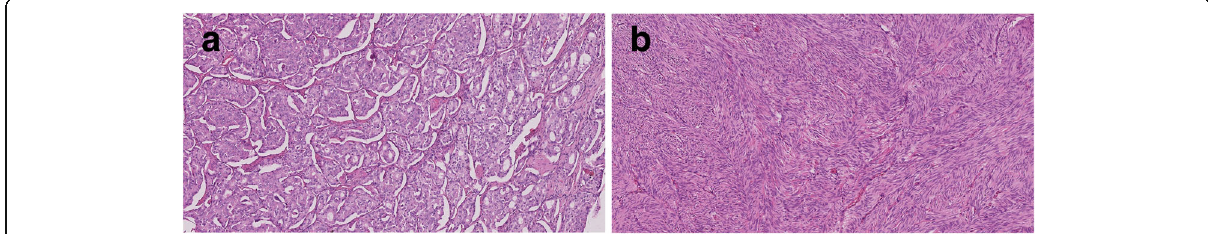
Fig. 4 a Histopathology - NET G1, tumor with solid and nesting masses of monotonous small round cells. Cells have moderate amount of finely granular cytoplasm, small nucleoli and “ salt and pepper ” chromatin pattern. No mitotic figures are seen, HE staining, 100x. b Histopathology - GIST, the tumor cells show plump spindled cell morphology with minimal atypia, without mitotic figures. The cells are arranged in whorls or short intersecting fascicles, with frequent and prominent nuclear palisading, HE staining,